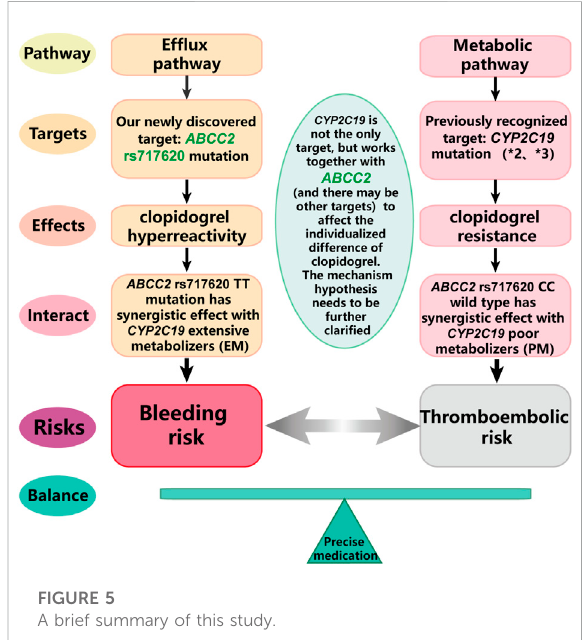
FIGURE 5 A brief summary of this